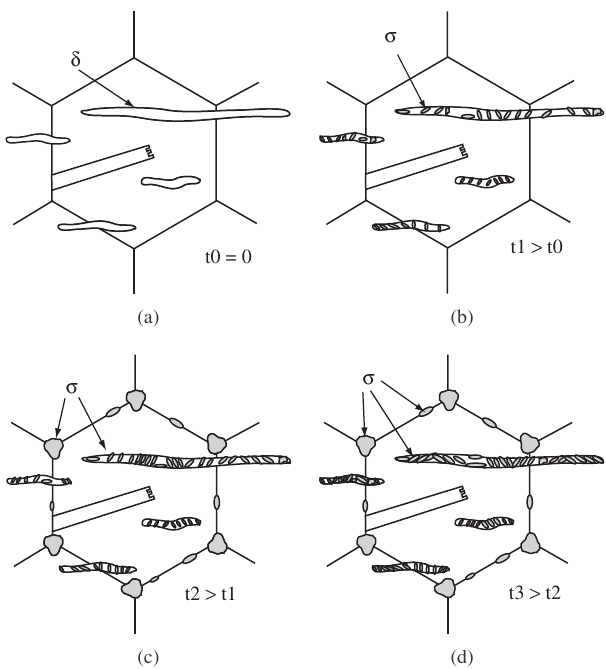
Figure 7. Schematic representation of sigma phase precipitation in an auste- nitic stainless steel containing delta ferrite 34,35,46